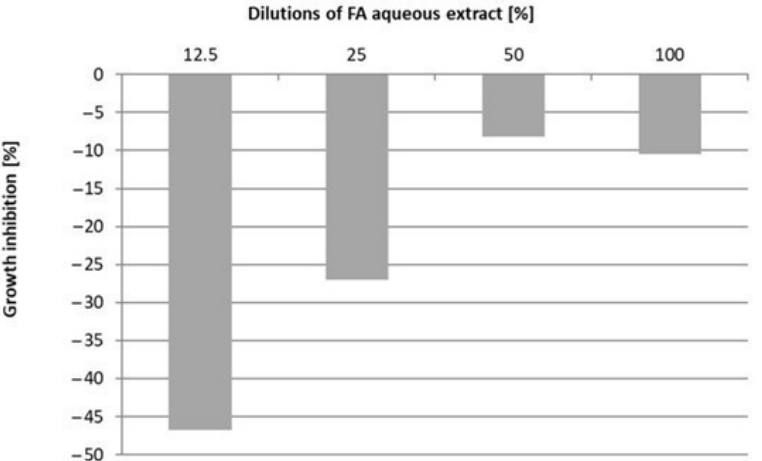
Figure 2. Growth inhibition of test plants (percentage inhibition) for different dilutions of FA aqueous extract.